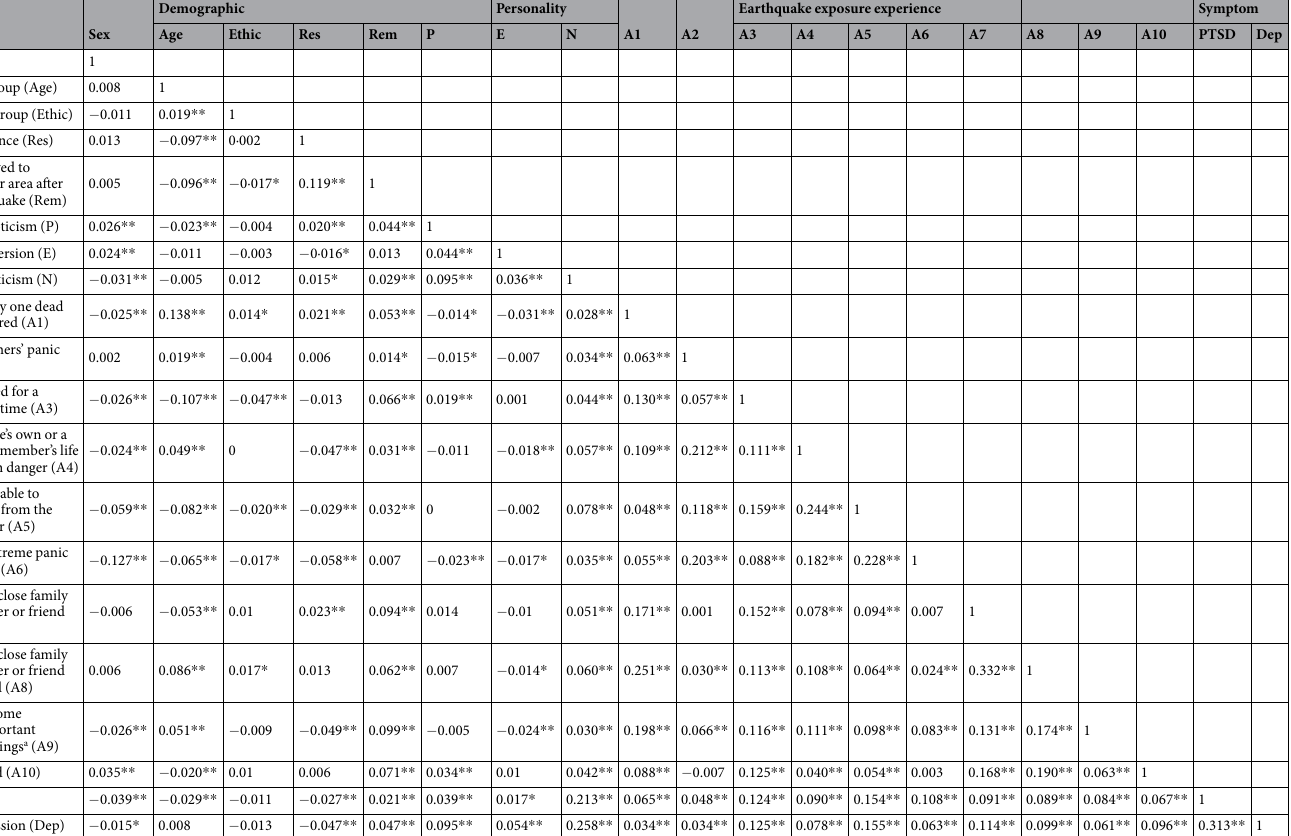
Table 2. Inter-correlation Coefficient Matrix of Demographic, Personality Characteristics, Earthquake exposure experiences and Mental Health